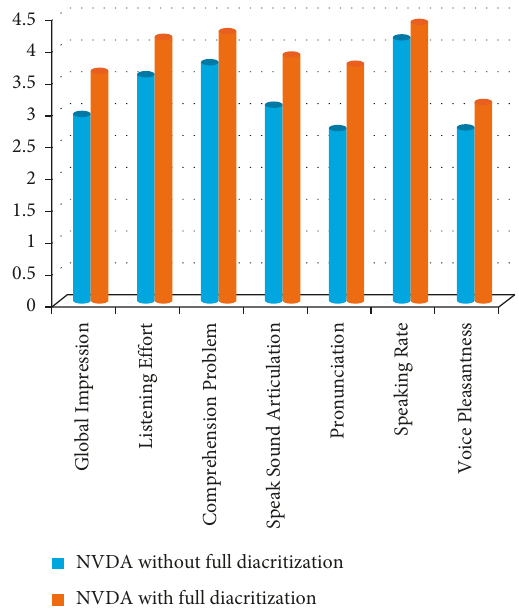
Figure 2: MOS questionnaire results comparing the quality of the output in NVDA before and after full